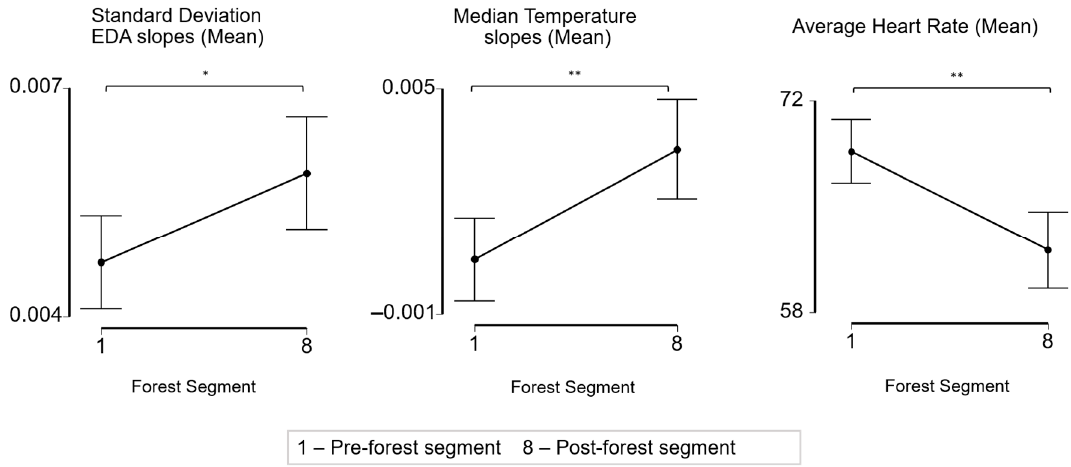
Figure 5. Effect of forest bathing on the mean standard deviation of the EDA slopes, mean of the median temperature slopes, and mean average heart rate from pre-forest activity segment to post-forest activity segment. * p < 0.05, ** p < 0.01, paired t -test and Wilcoxon signed rank